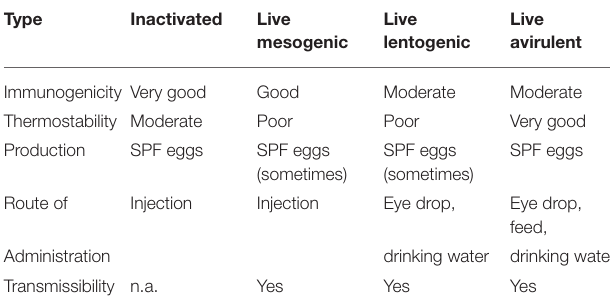
TABLE 2 | Characteristics of Newcastle disease vaccines [Young et al.